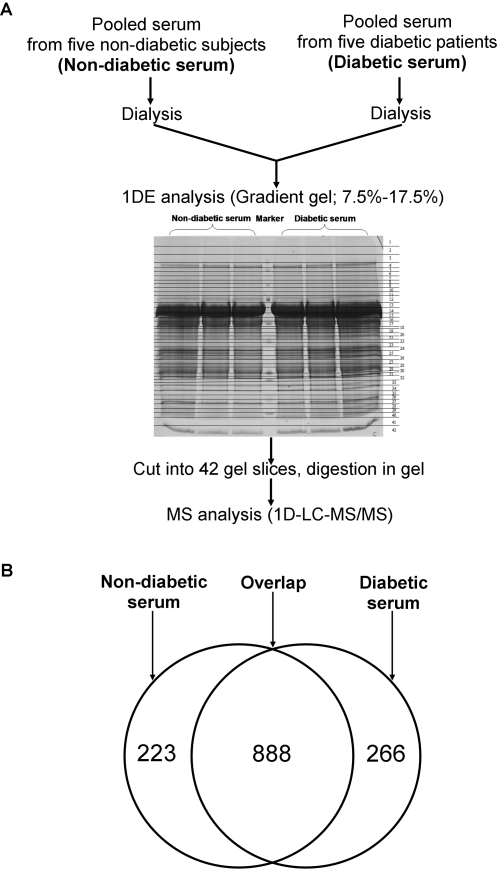
Overview of Idnetitication of proteins in non-diabetic and diabetic serum.(A) Scheme of label-free strategy to differential protein identification in non-diabetic and diabetic serum. Pooled serum samples from five non-diabetic and five diabetic sera were separated respectively by gel electrophoresis. Each gel lane was divided into 42 regions and each section was processed for mass spectrometry. (B) 1377 proteins were identified by at-least two peptide spectral counts in either serum. 888 overlapped proteins were identified both in non-diabetic and diabetic serum, whereas 223 proteins were identified uniquely from the non-diabetic serum and 266 proteins were found uniquely from the diabetic serum.